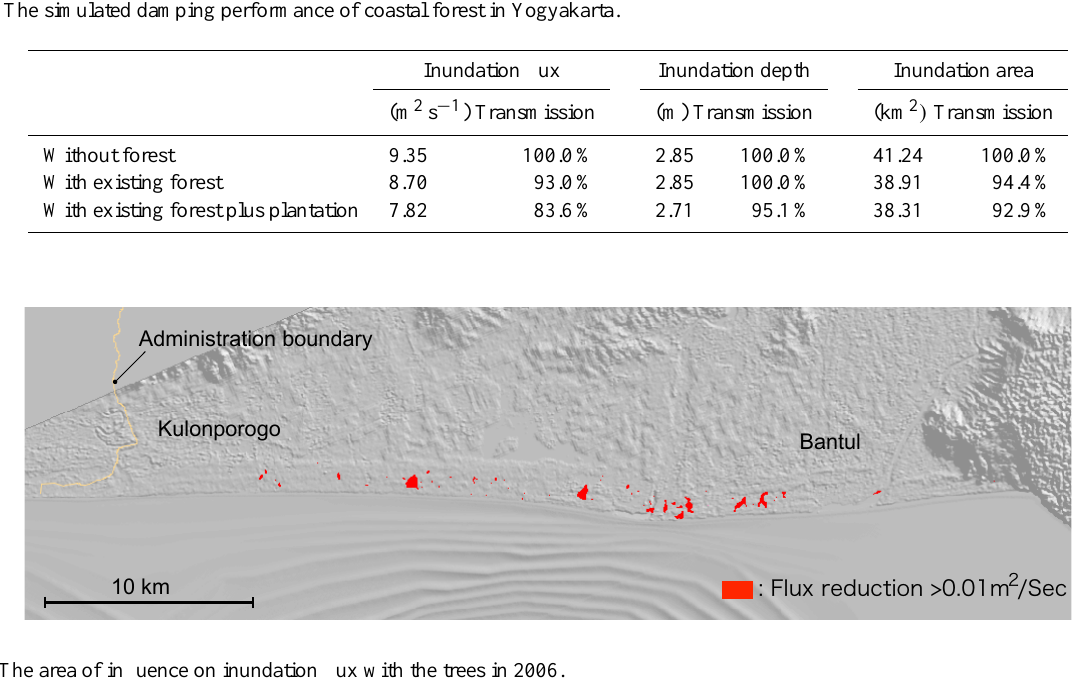
Fig. 13. The area of influence on inundation flux with the plantation Table 6 indicates the transmission reduction with the planned plantation by the numerical simulation and the exponential models. Total length of the existing forest in 2006 was 15.42 km out of 40 km total coast length, and average forest width was 40 m. The transmissions with 40 m of the forest width were calculated as 88.1, 94.8 and 96.8% in inundation flux, depth, and area respectively (Eq. 22, 21, and 20). These transmissions are only for behind the existing forest. In order to obtain the contribution of these transmissions in total inundation area, we calculated the weighted average against the total coastline length using Eq.23 by setting it equal to 0 km.